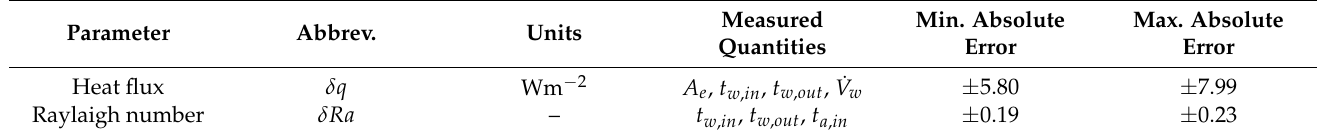
Table 4. Absolute errors of the calculated parameters for heat exchanger No. 1.